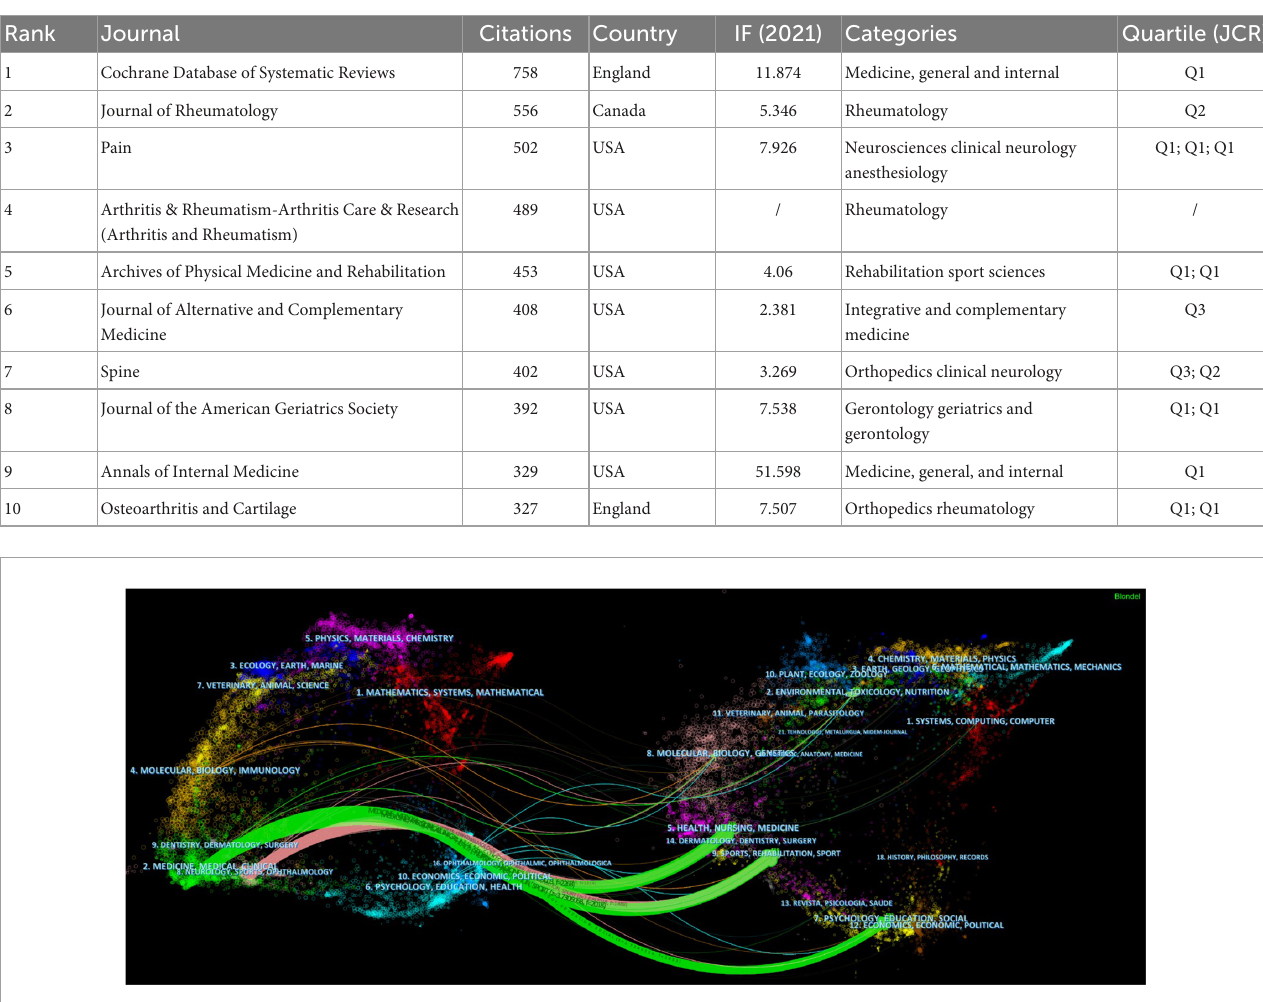
TABLE 2 Top 10 cited journals with the highest frequency with traditional Chinese exercises for musculoskeletal disorders. Rank